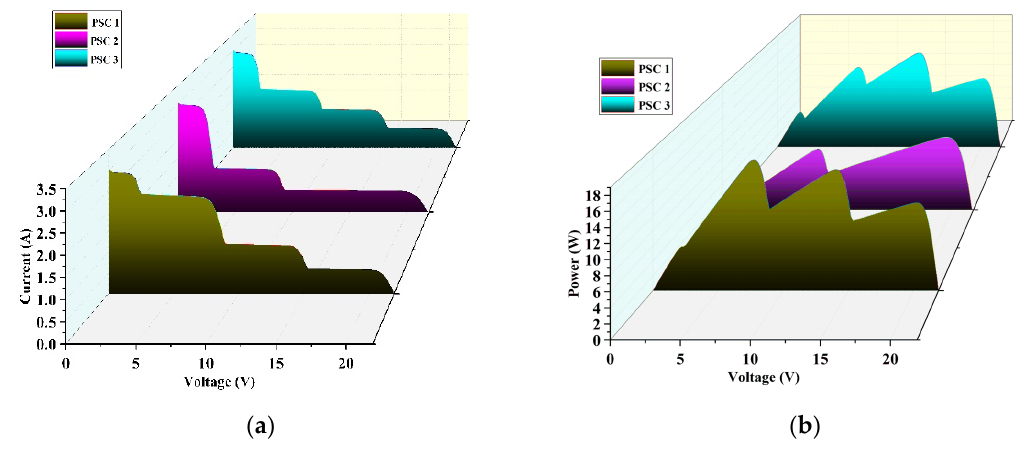
Figure 22. PSCs pattern ( a ) P-V ( b ) I-V.